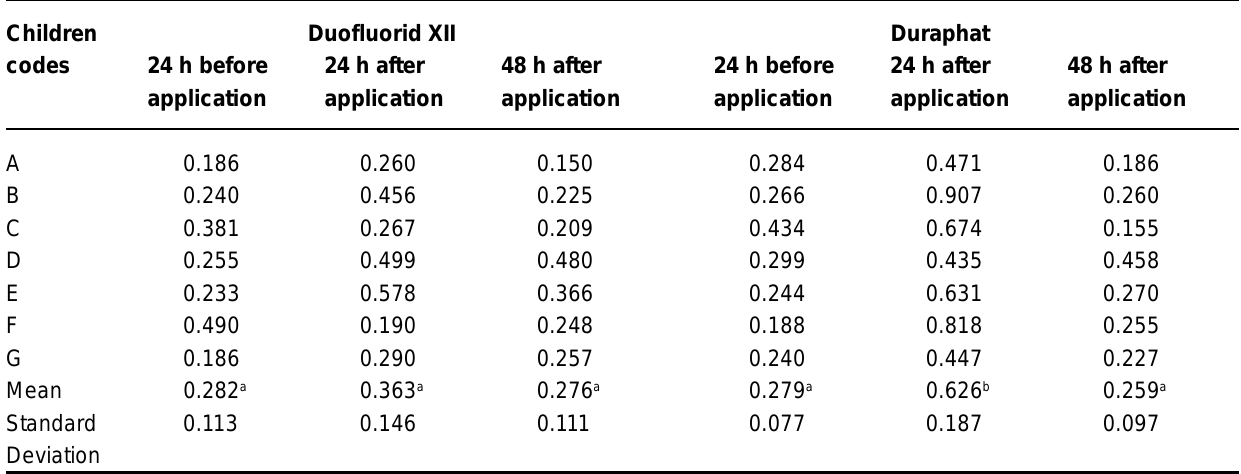
Different letters indicate statistically significant difference